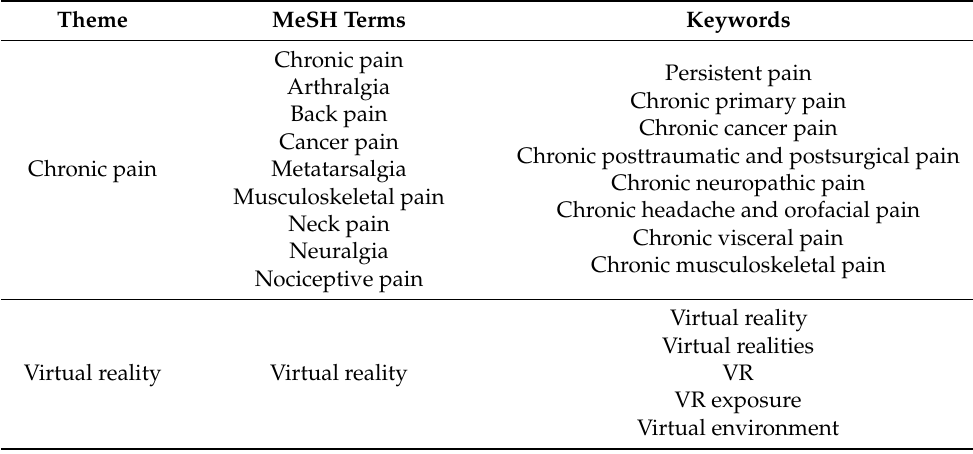
Table 1. Medical subject headings (MeSH) terms and keywords. Theme MeSH